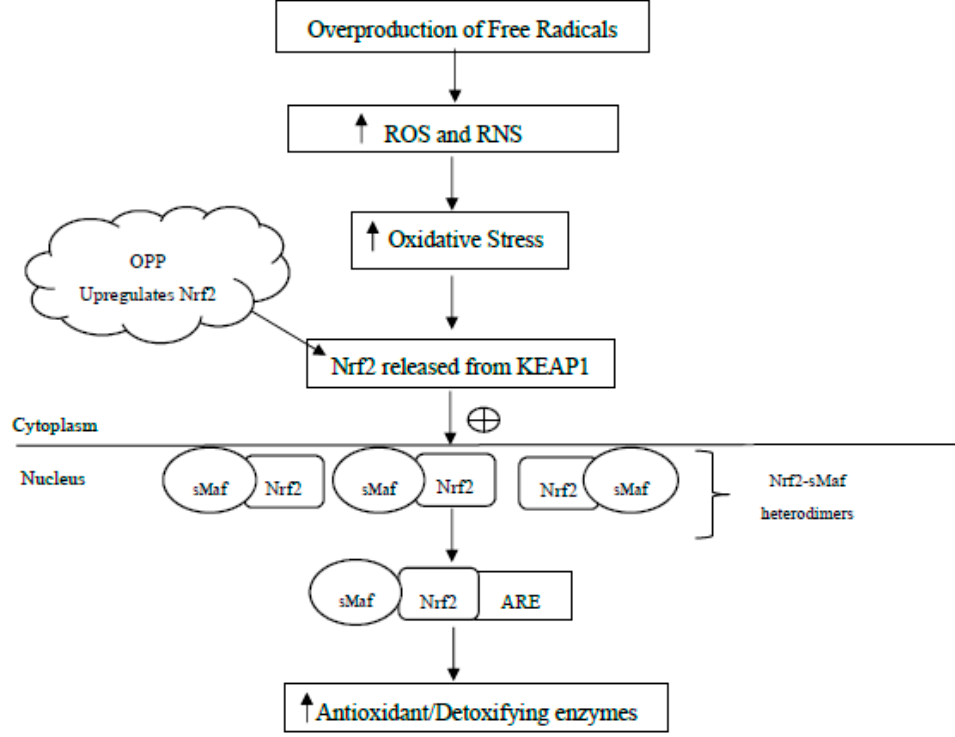
Figure 1. Keap-Nrf2-ARE pathway. A proposed mechanism for the antioxidant property of OPP. ⊕ : activate or stimulate; RNS: reactive nitrogen species; ROS: reactive oxygen species; Nrf2: nuclear factor erythroid 2-related factor 2; KEAP1: Kelch-like ECH-associated protein 1; sMaf: small Maf proteins; ARE: antioxidant response element.